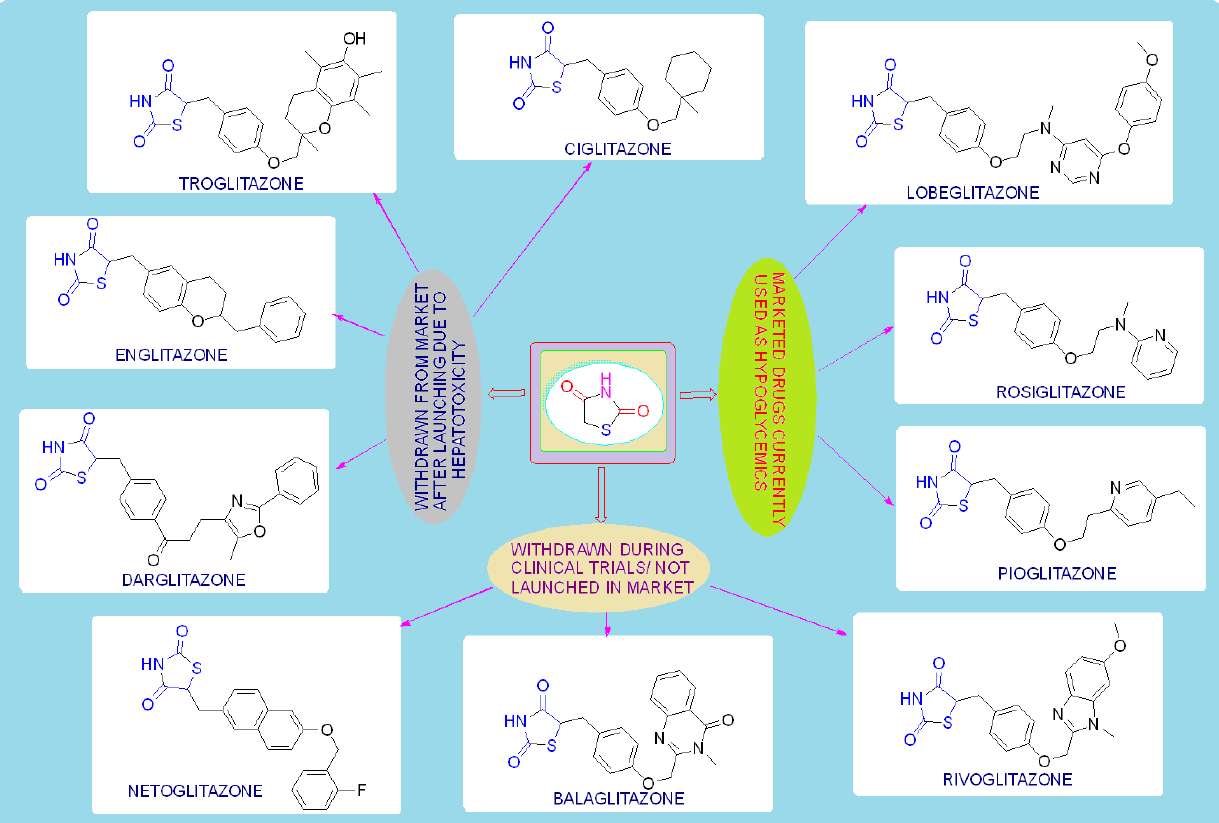
Figure 2. Antidiabetic molecules developed with the thiazolidin-2,4-dione moiety.